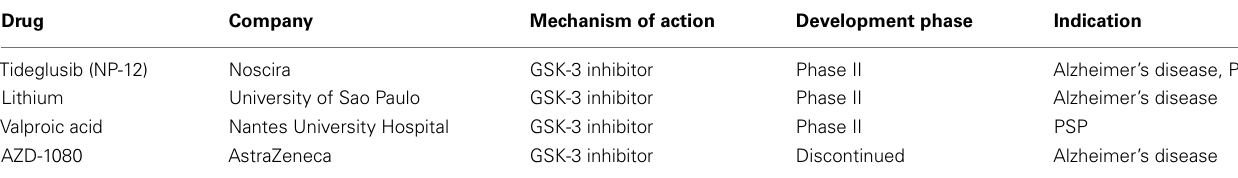
Table 1 | Selected GSK-3 kinase inhibitor drugs in clinical development for the treatment of